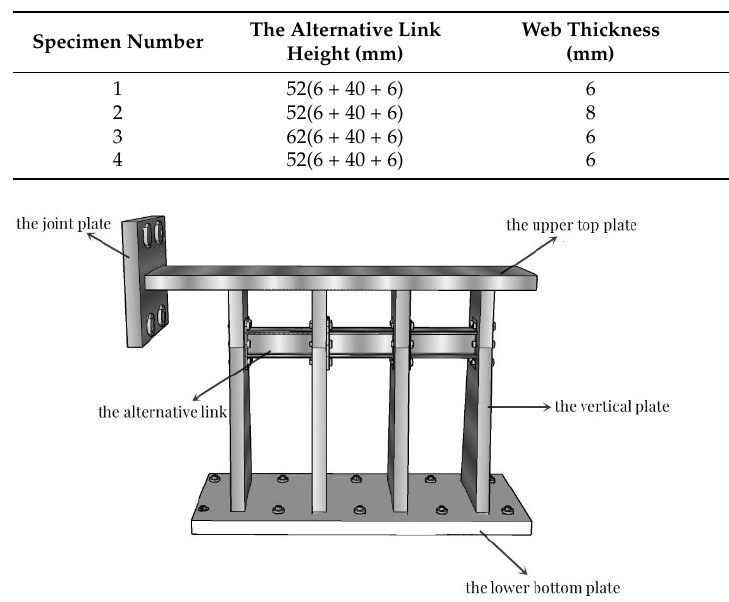
Figure 3. The structure design of test specimens.